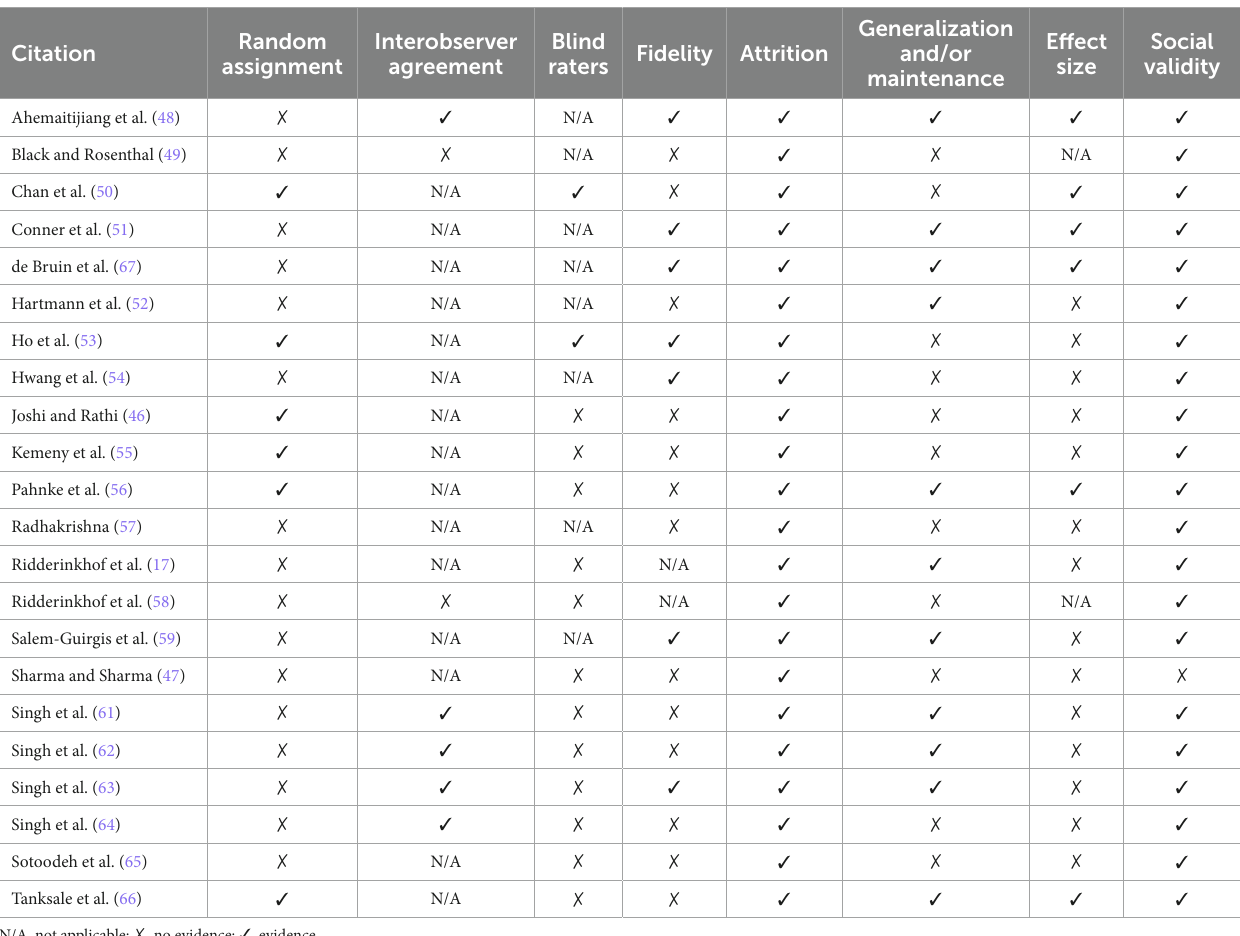
TABLE 3 Secondary quality indicators of group research.